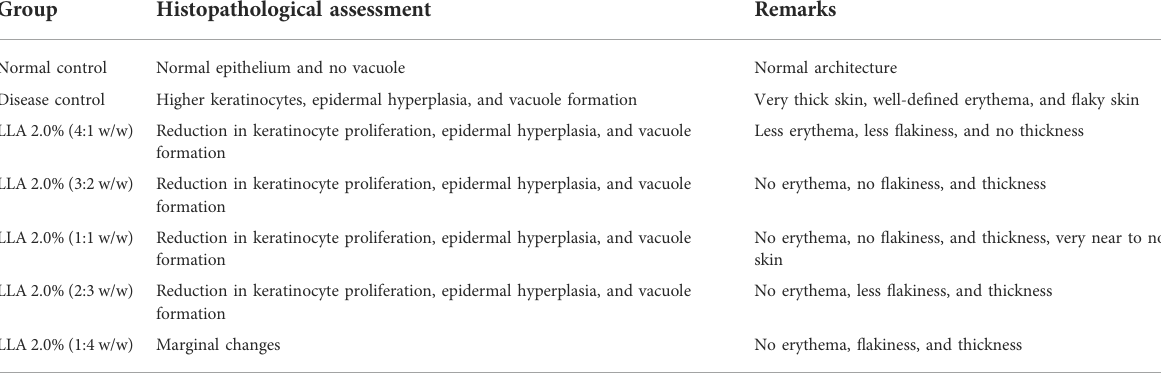
TABLE 2 Histopathological features of linalool and linalyl acetate treated skin.